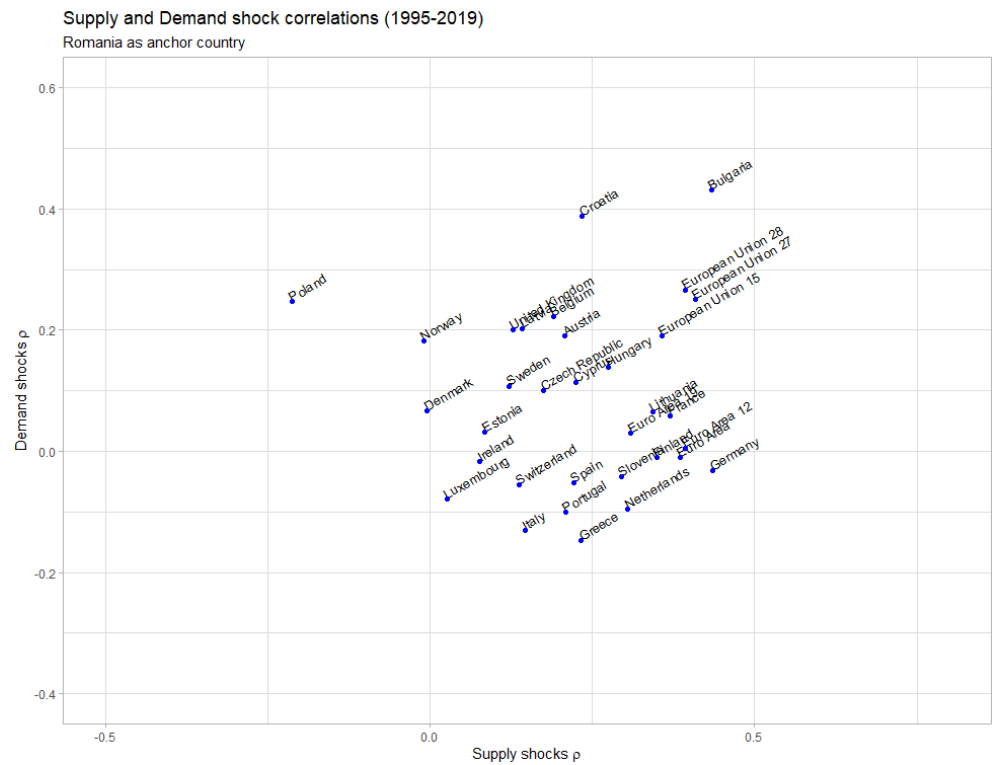
Figure 6. Bidimensional mapping of the correlation coefficients (ρ) between sup ply and demand shocks series recuperated from the BQ model using the whole sample (1995-2019) – Romania as anchor country. Source: own elaboration.